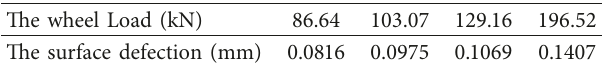
Table 5: The surface defection.